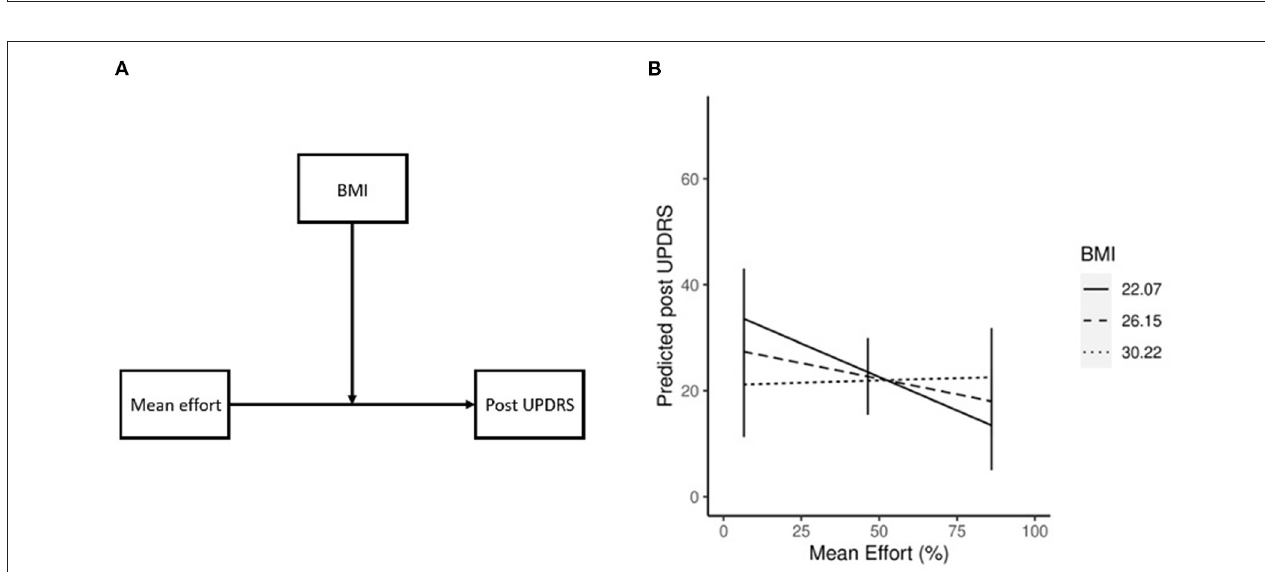
FIGURE 3 | Conceptual diagram of the effect of BMI (A) , where the effect of effort on post UPDRS is influenced by BMI. Moderating effect of BMI on mean effort (B) . Simple slopes plot demonstrating the moderating effect of BMI on mean effort. As BMI increases the effect of effort on post UPDRS